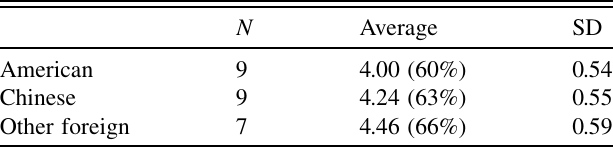
TABLE I. Numbers of American, Chinese, and other foreign graduate students, their averages (and percentage of those aver- ages out of the maximum PCK score) and standard deviations (SD) for the PCK scores obtained for determining introductory student difficulties on the TUG-K out of a maximum PCK score of 6.70.